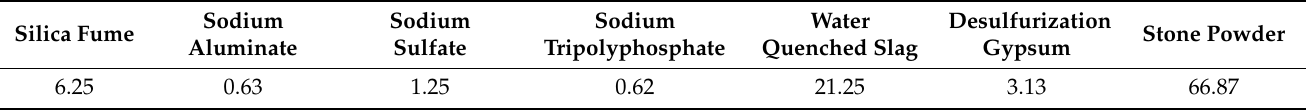
Table 1. Components of activator (wt %).